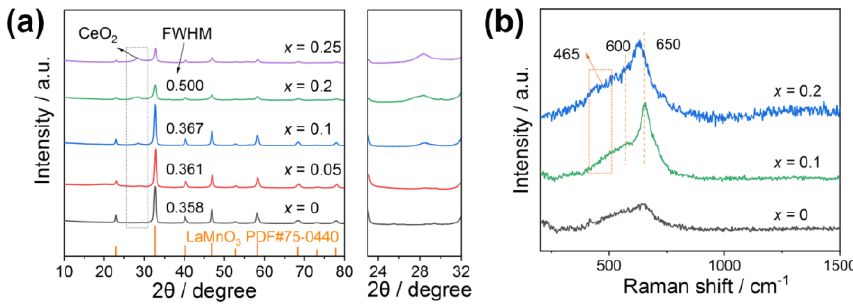
Figure 2. ( a ) XRD patterns, ( b ) Raman patterns of La 1- x Ce x MnO 3 (0 ≤ x ≤ 0.25 ) catalysts.